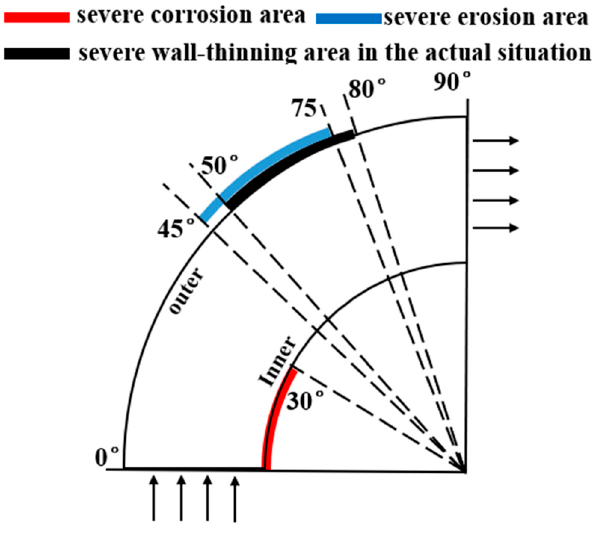
Figure 14. Comparison between the simulation results and the actual situation.